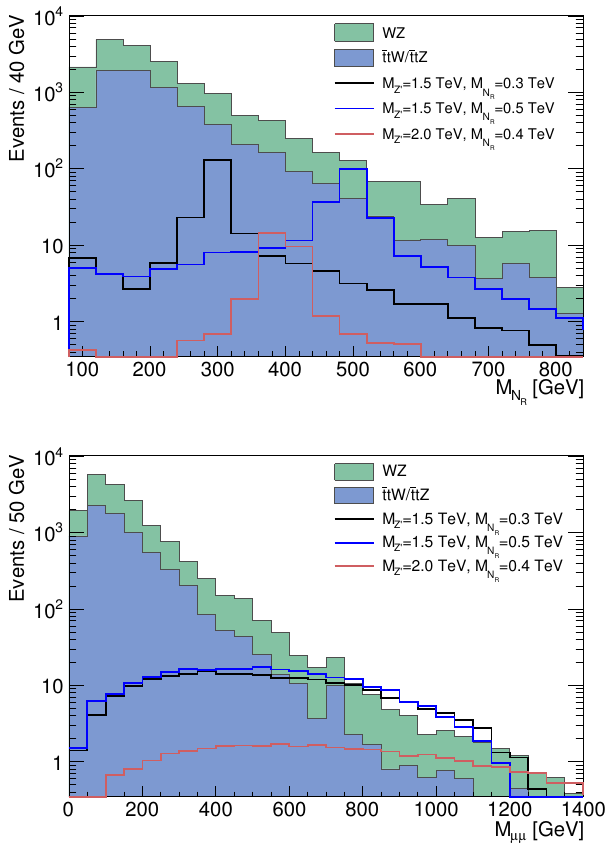
Figure 4 . Reconstructed N R mass (top) and same-sign di-muon invariant mass (bottom) after initial event selection, showing several benchmark signal